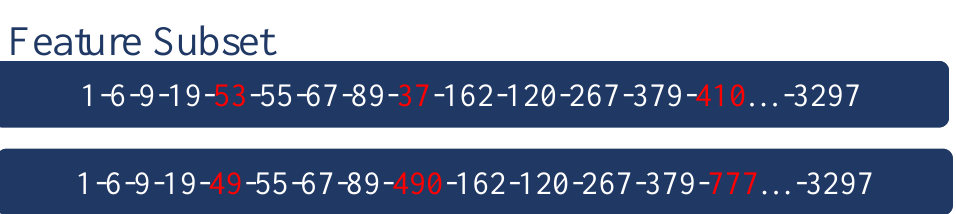
Figure 4. An instance of mutation in a feature subset in an individual. It randomly selects a number of codes and mutates into a certain number randomly. The limited range of this number is the number of features, which is the same as the range of individual codes. The pseudo-code of the whole process of Crossover and Mutation Algorithm 2 is as follows.